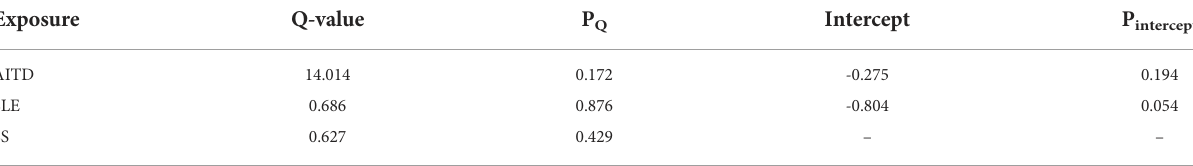
TABLE 1 Heterogeneity and pleiotropy tests for the associations of autoimmune diseases with NMOSD. Exposure